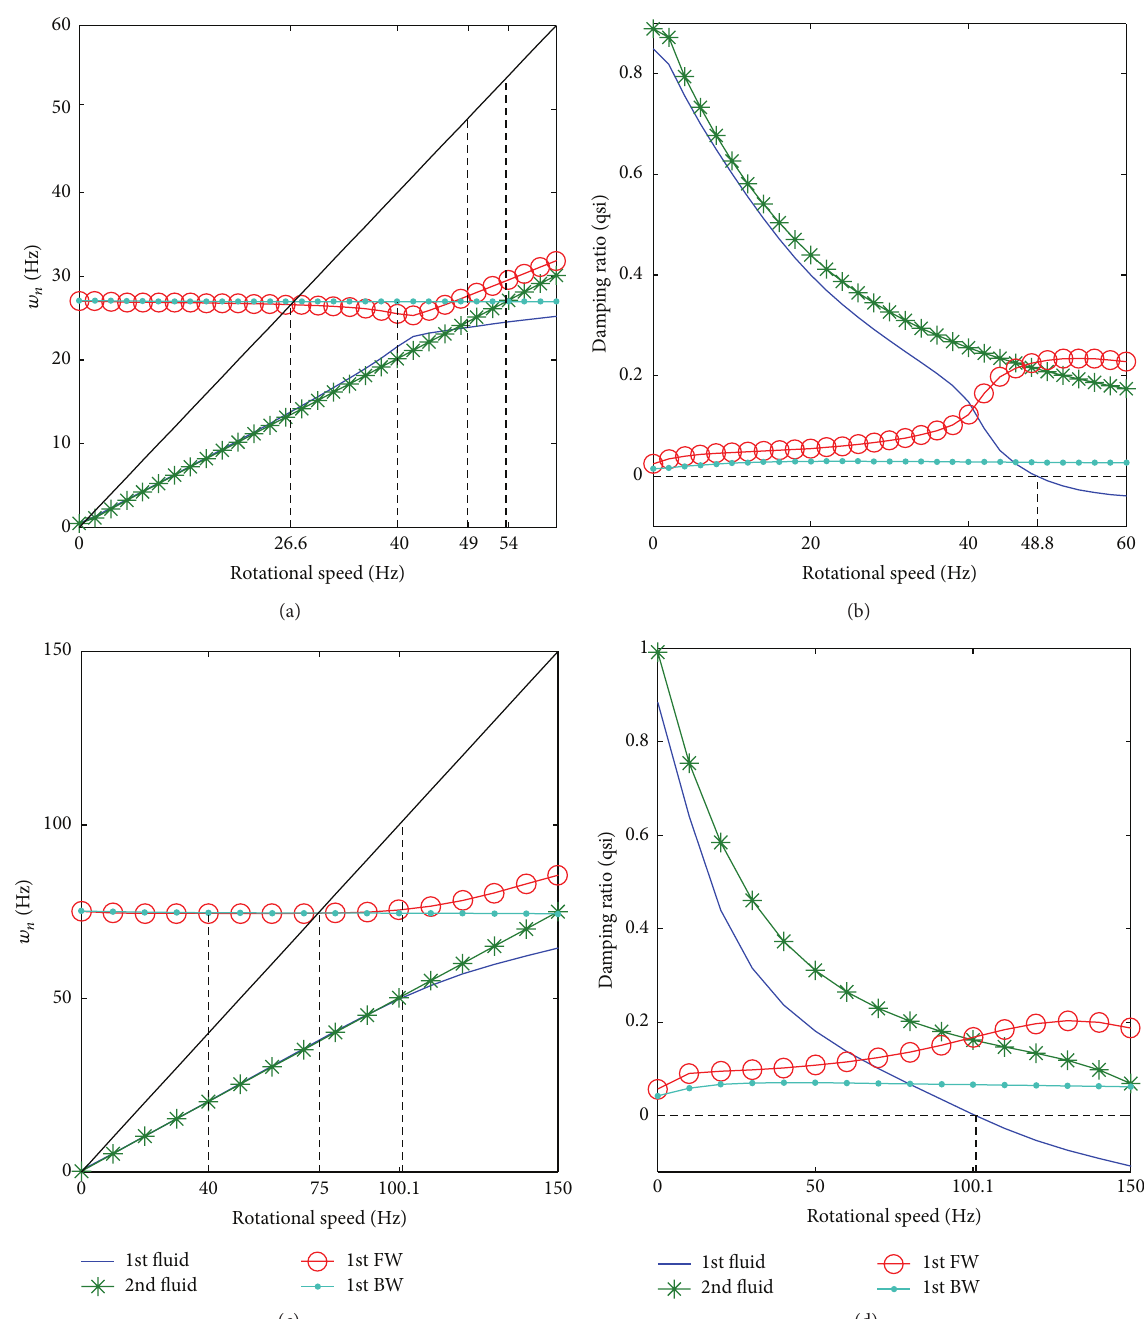
Figure 6: (a) Campbell diagram of configuration A; (b) modal damping of configuration A; (c) Campbell diagram of configuration B; (d) modal damping of configuration